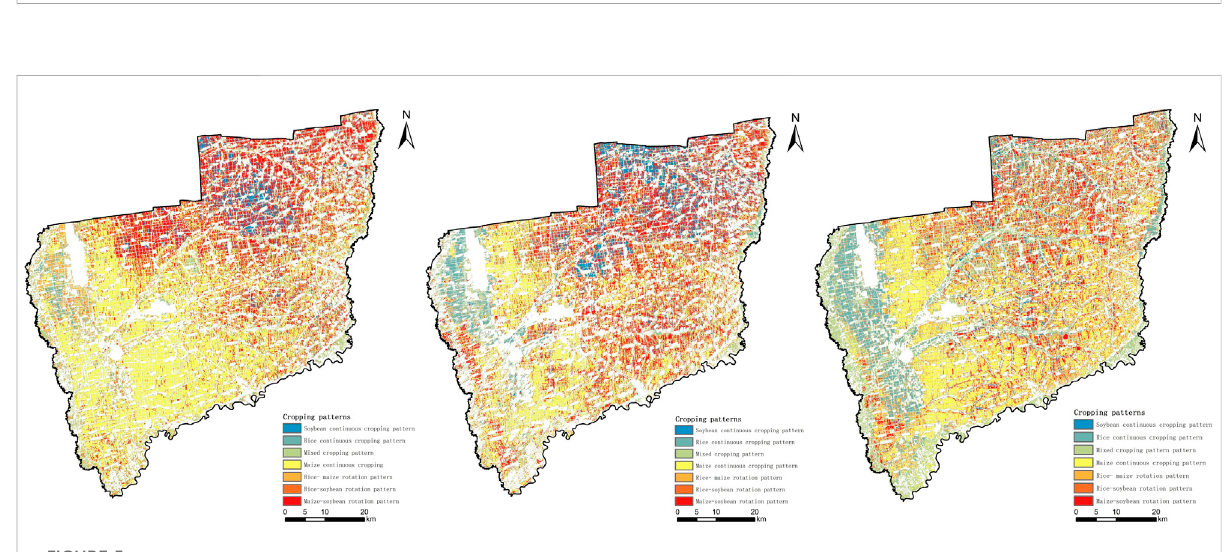
FIGURE 5 Evolution of the spatial distribution of the plots of various cropping